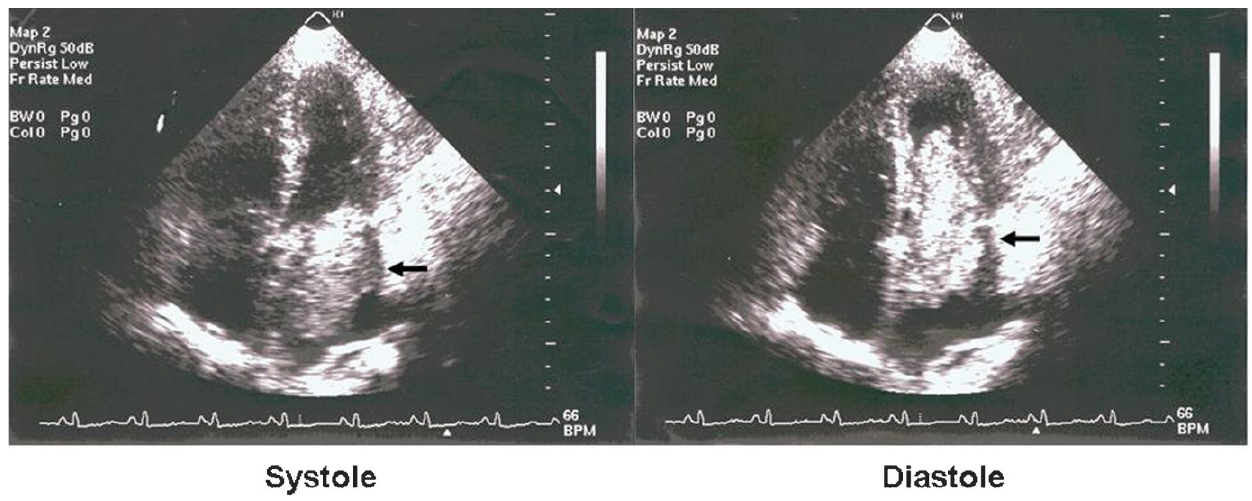
Figure 1 - Giant obstructive left atrial mixoma (arrows) in systole